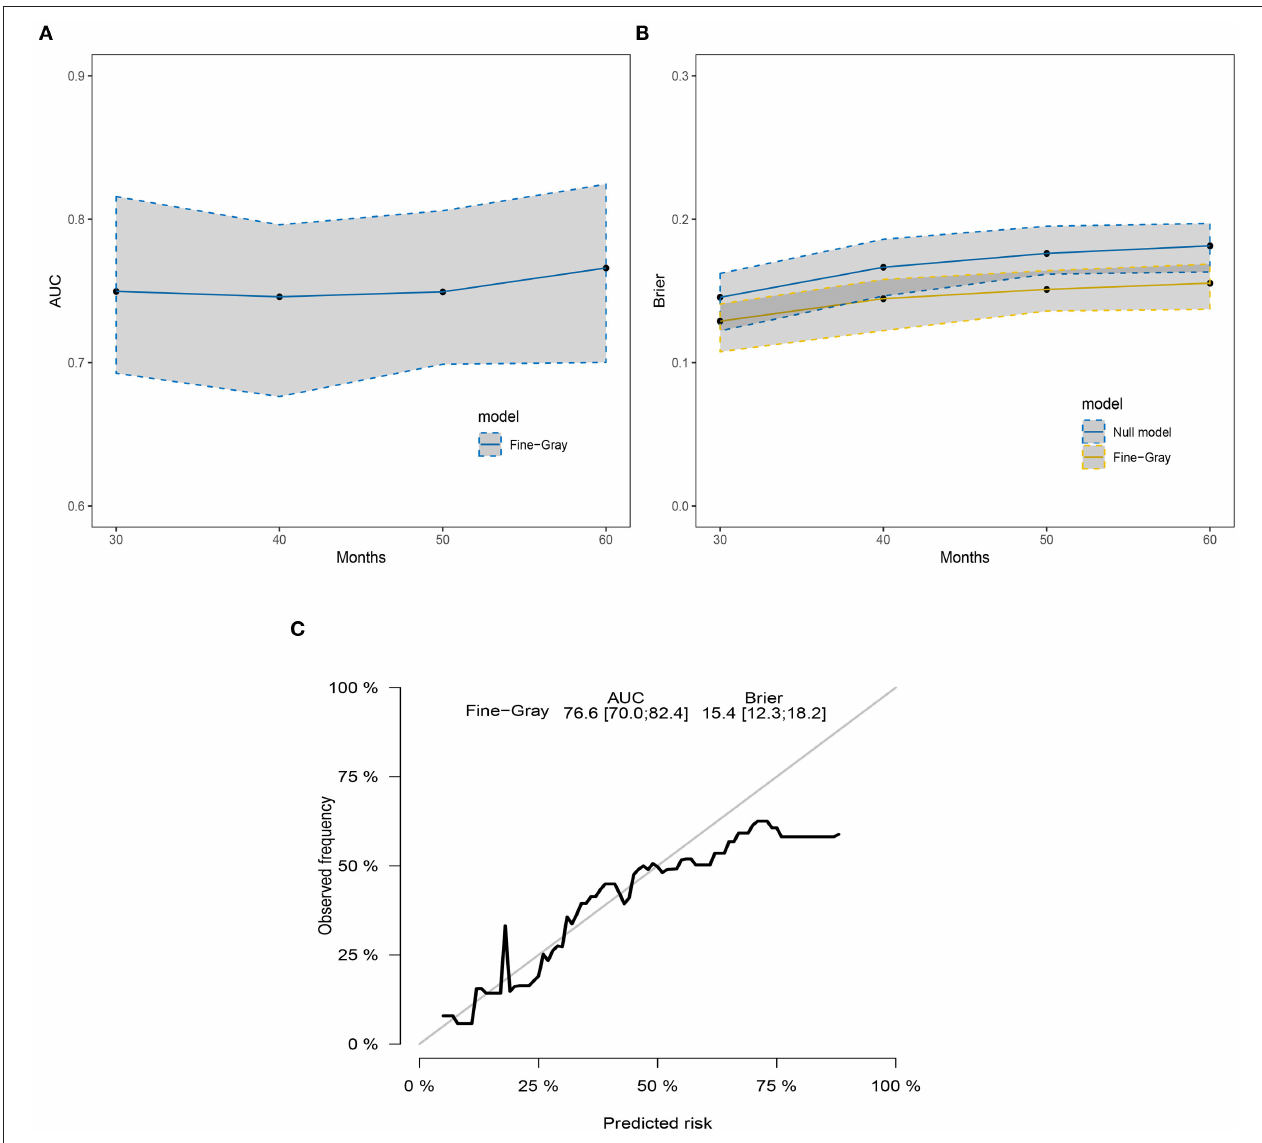
FIGURE 5 | The discrimination and calibration of the SH model-based nomogram. (A) The time-dependent AUC graph. (B) The brier value graph according to the time. (C) The 5-year calibration